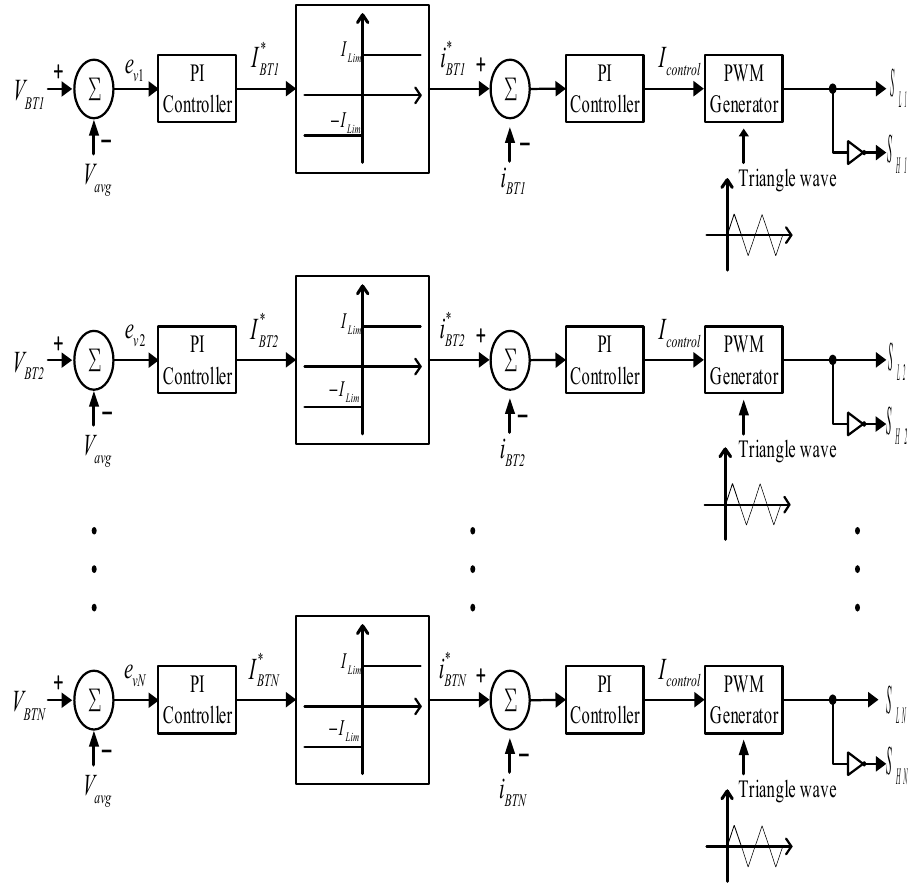
Table 3. Uniform charge and discharge control switch on time comparison table (N ≥ 1).